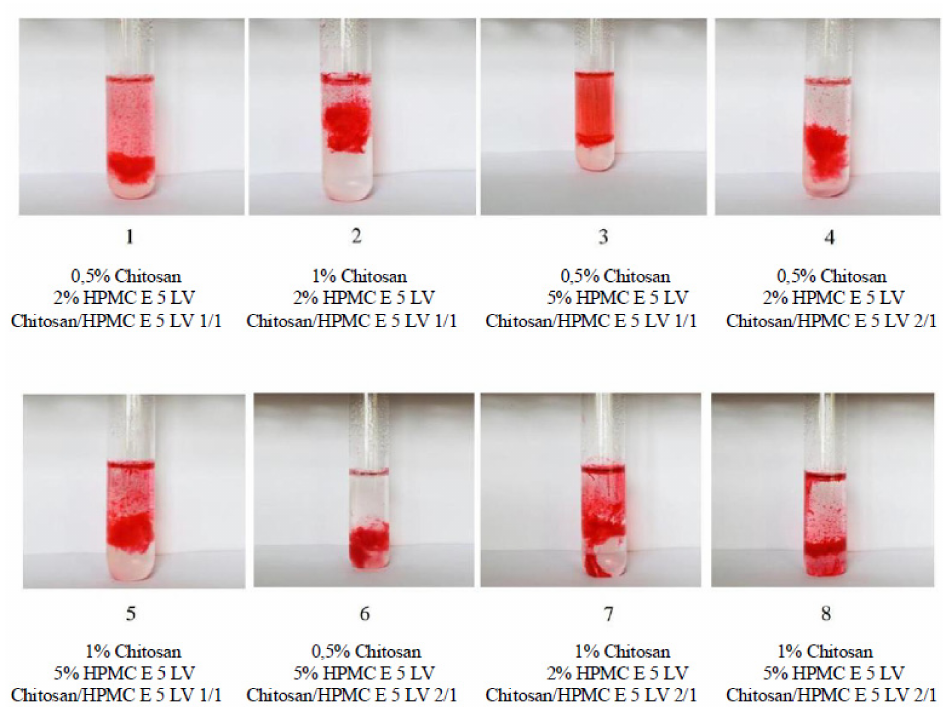
Figure 1. Highlighting of Congo red gelling for the analyzed colloidal systems. The contact angle values for the polymer preparations were intended to evaluate their ability to display on the ocular surface. Table 4 presents the experimental data obtained after analysis of the droplets from the samples taken, captured with the help of the CAM 101 tensiometer-goniometer at 23 ◦ C and at 35 ◦